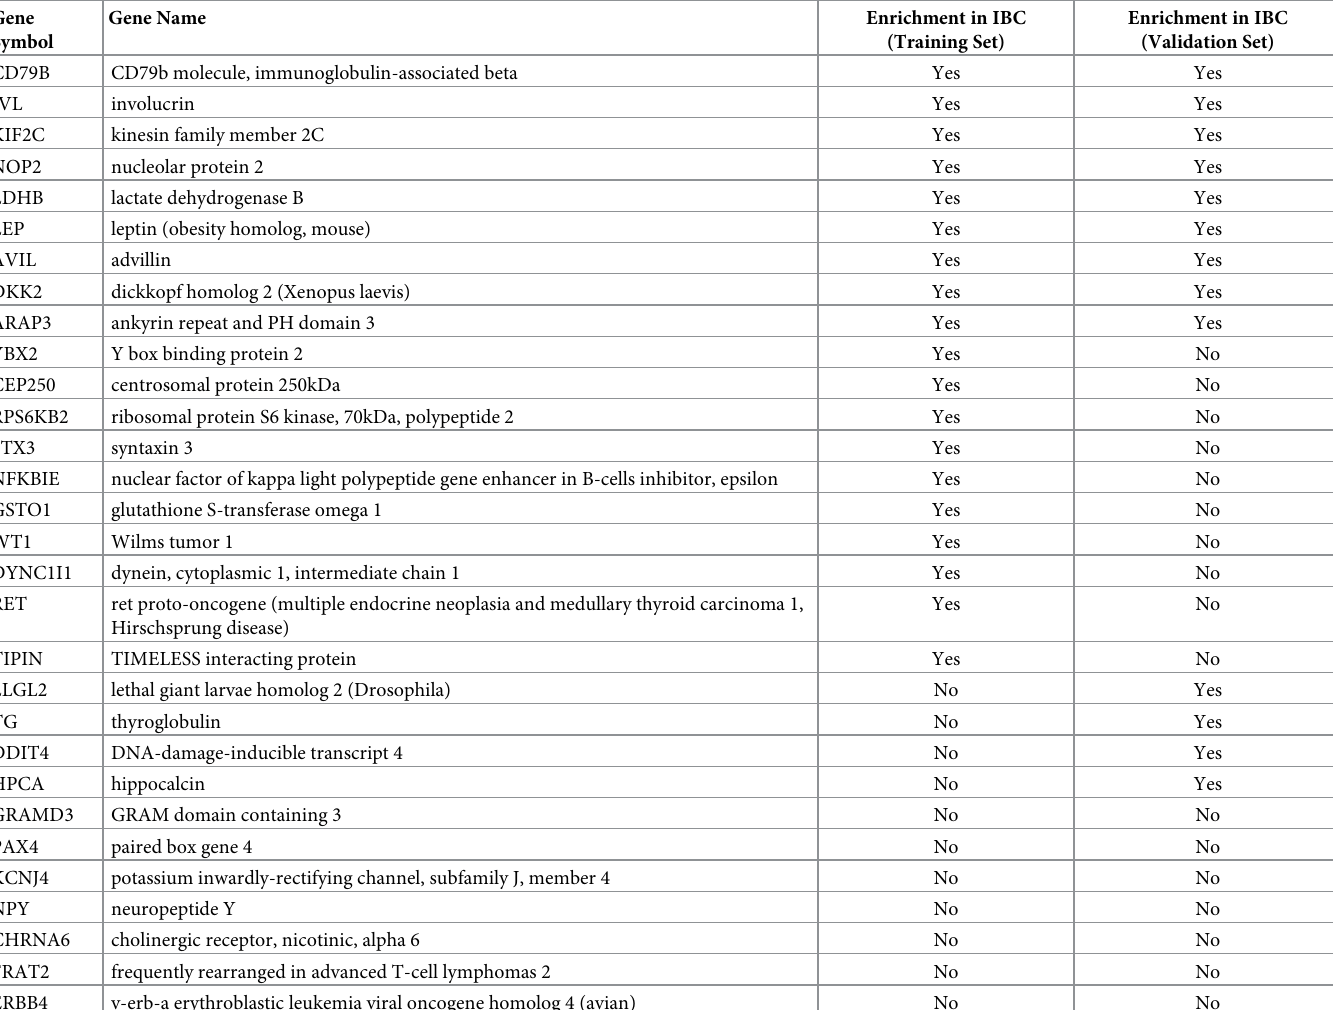
Table 5. List of genes in Inv5 signature and genes enriched in IBC versus non-IBC. Gene